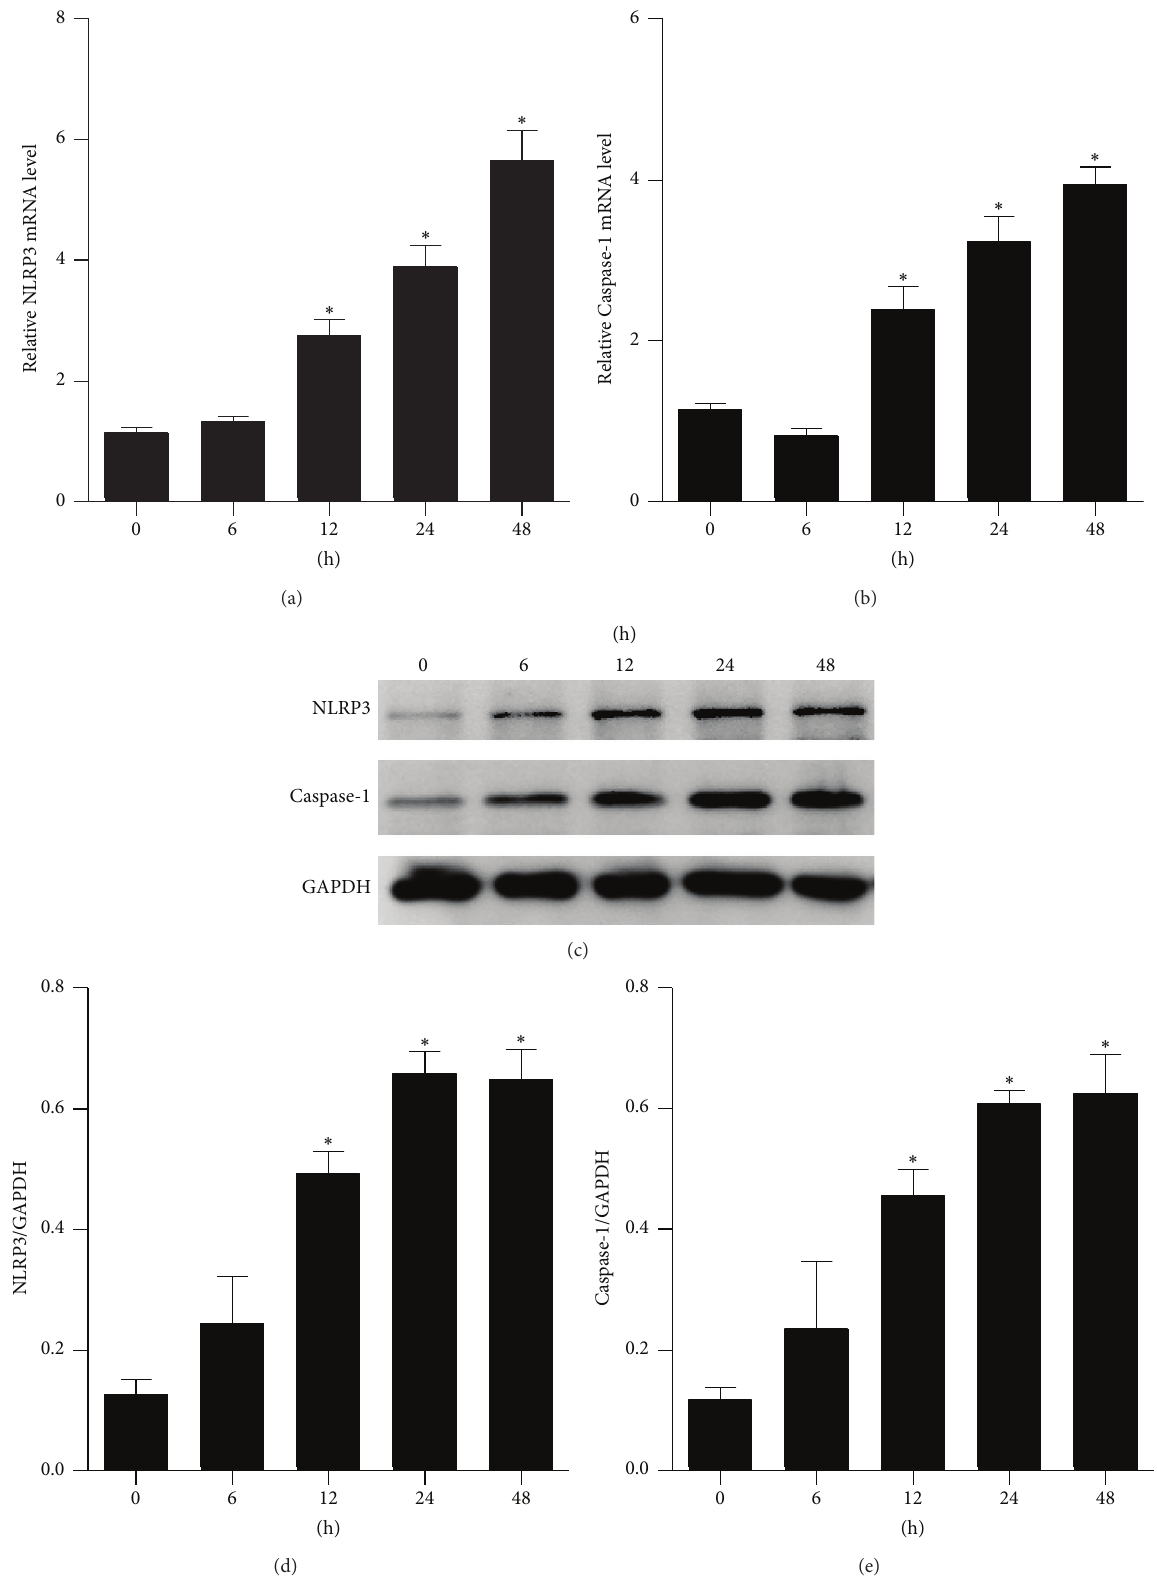
Figure 2: NLRP3 and Caspase-1 were activated in rat lungs after burn. Rats were subjected to burn injury. The mRNA expression ((a) and (b)) of NLRP3 and Caspase-1 in lung tissue after burn over time. The protein levels ((c), (d), and (e)) of NLRP3 and Caspase-1 in lung tissue from severely burned rats over time. The values presented are mean ± SEM ( 𝑛 = 6 per group). ∗ 𝑃 < 0.05 , compared to the value at 0